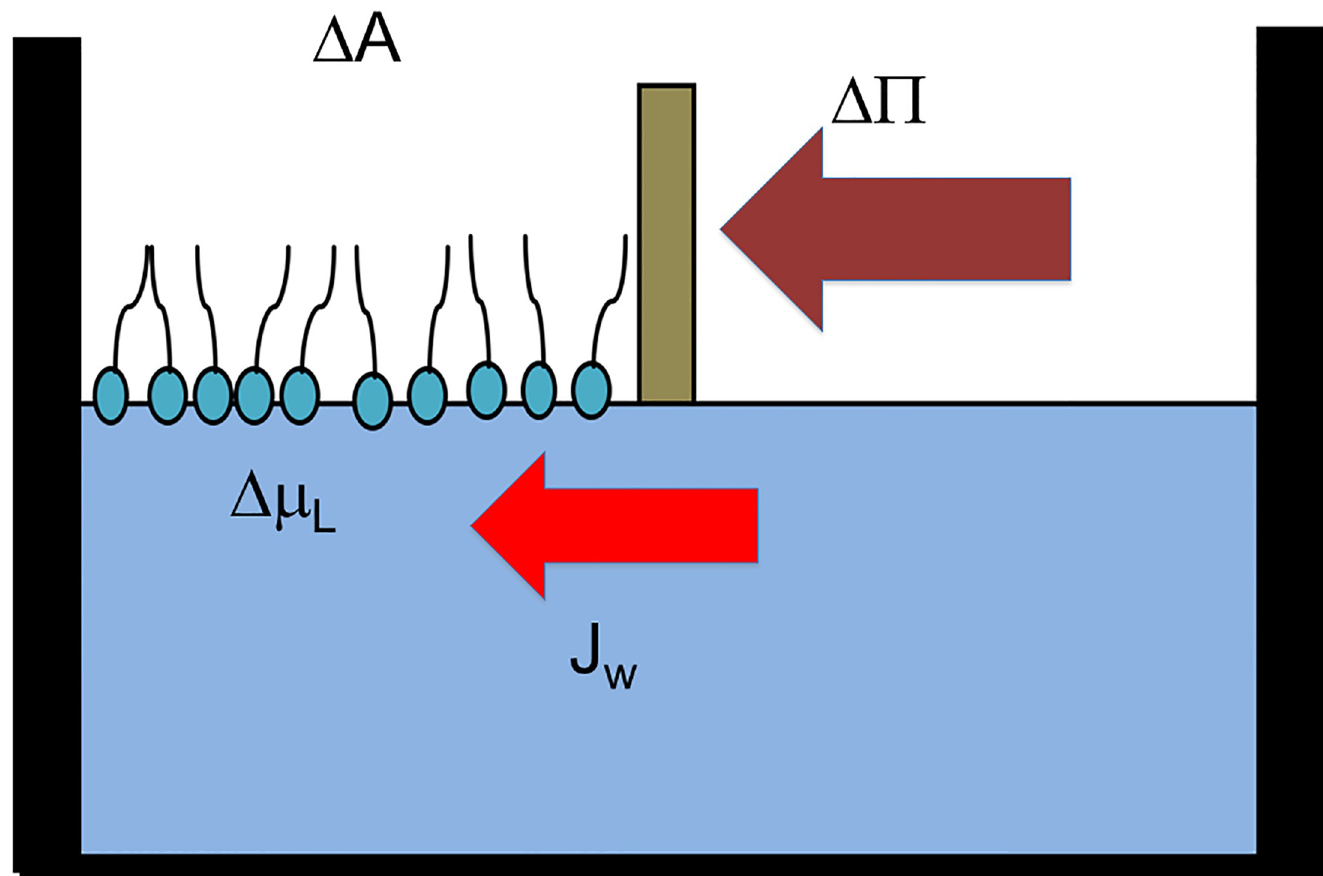
Fig 4. Schematic representation of the compression of a lipid monolayer by a mobile barrier on the surface of a water solution. Horizontal violet arrow represents the surface pressure that produces area changes by the compression. Vertical red arrow represents the water outflux from the interphase upon compession. The increase in surface concentration of lipids at the surface of the left-hand compartment consequently decreases the chemical potential of water. Vertical violet arrow corresponds to the water influx to the interphase due to the difference in the chemical potential of water between bulk and the interphase. Horizontal red arrow is the expansion (area increase) produced by the water influx. If expansion is produced mechanically the area increased induces the water influx.